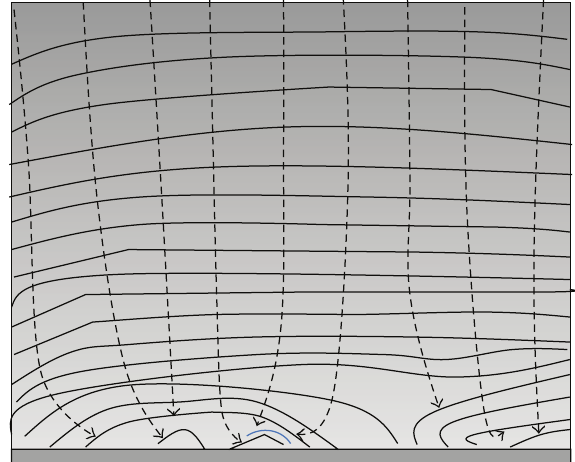
Figure 11: Di ff usion zones around growing nuclei ([26], repro- duced with